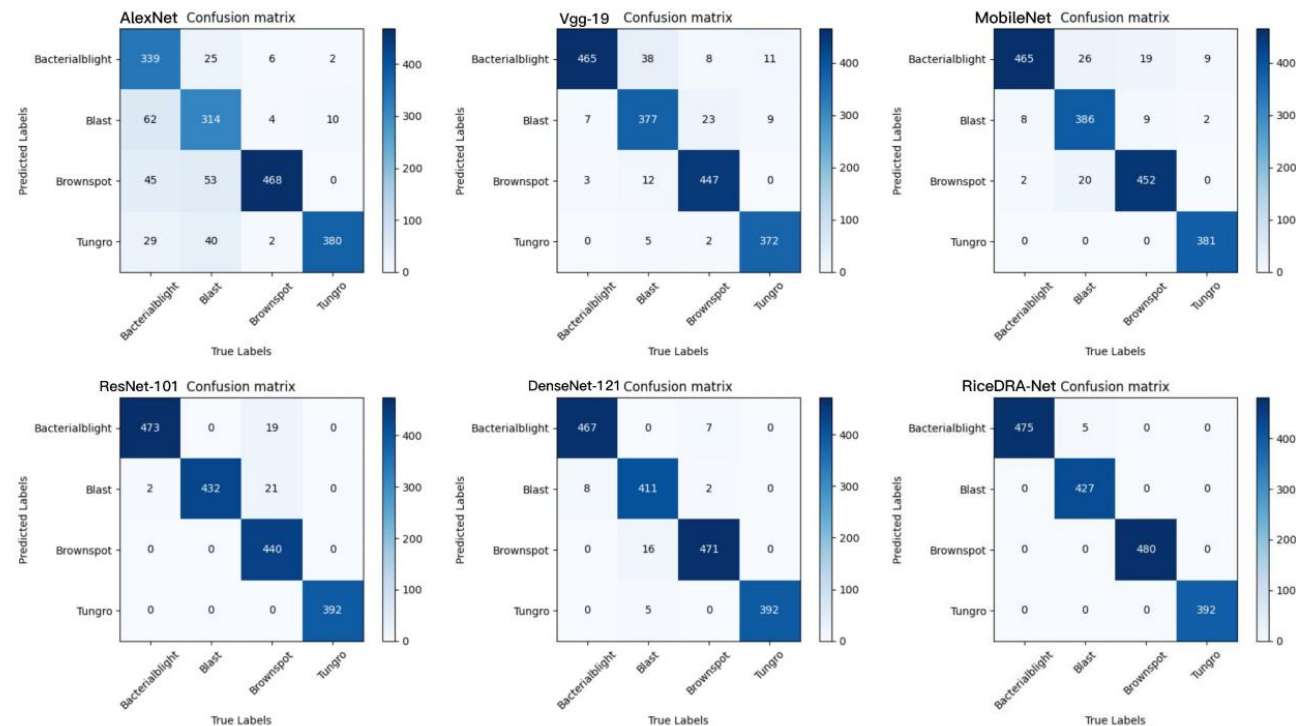
Figure 13. Confusion matrix generated with SBG-Dataset. Where the horizontal coordinate of the confusion matrix represented the true category, the vertical coordinate represented the predicted category, and the shades of colors in the squares represent different quantities, with darker colors representing higher quantities, we can see from Figure 13 that the precision for the three disease categories of blast, brown spot, and Tungro with a single context reached 100% on the model being studied. In addition, the precision for bacterial blight also reached 98.9%. Five experimental samples were misclassi- fied as bacterial blight instead of blast. These two disease categories, bacterial blight and blast, are somewhat similar in disease characteristics, which may cause